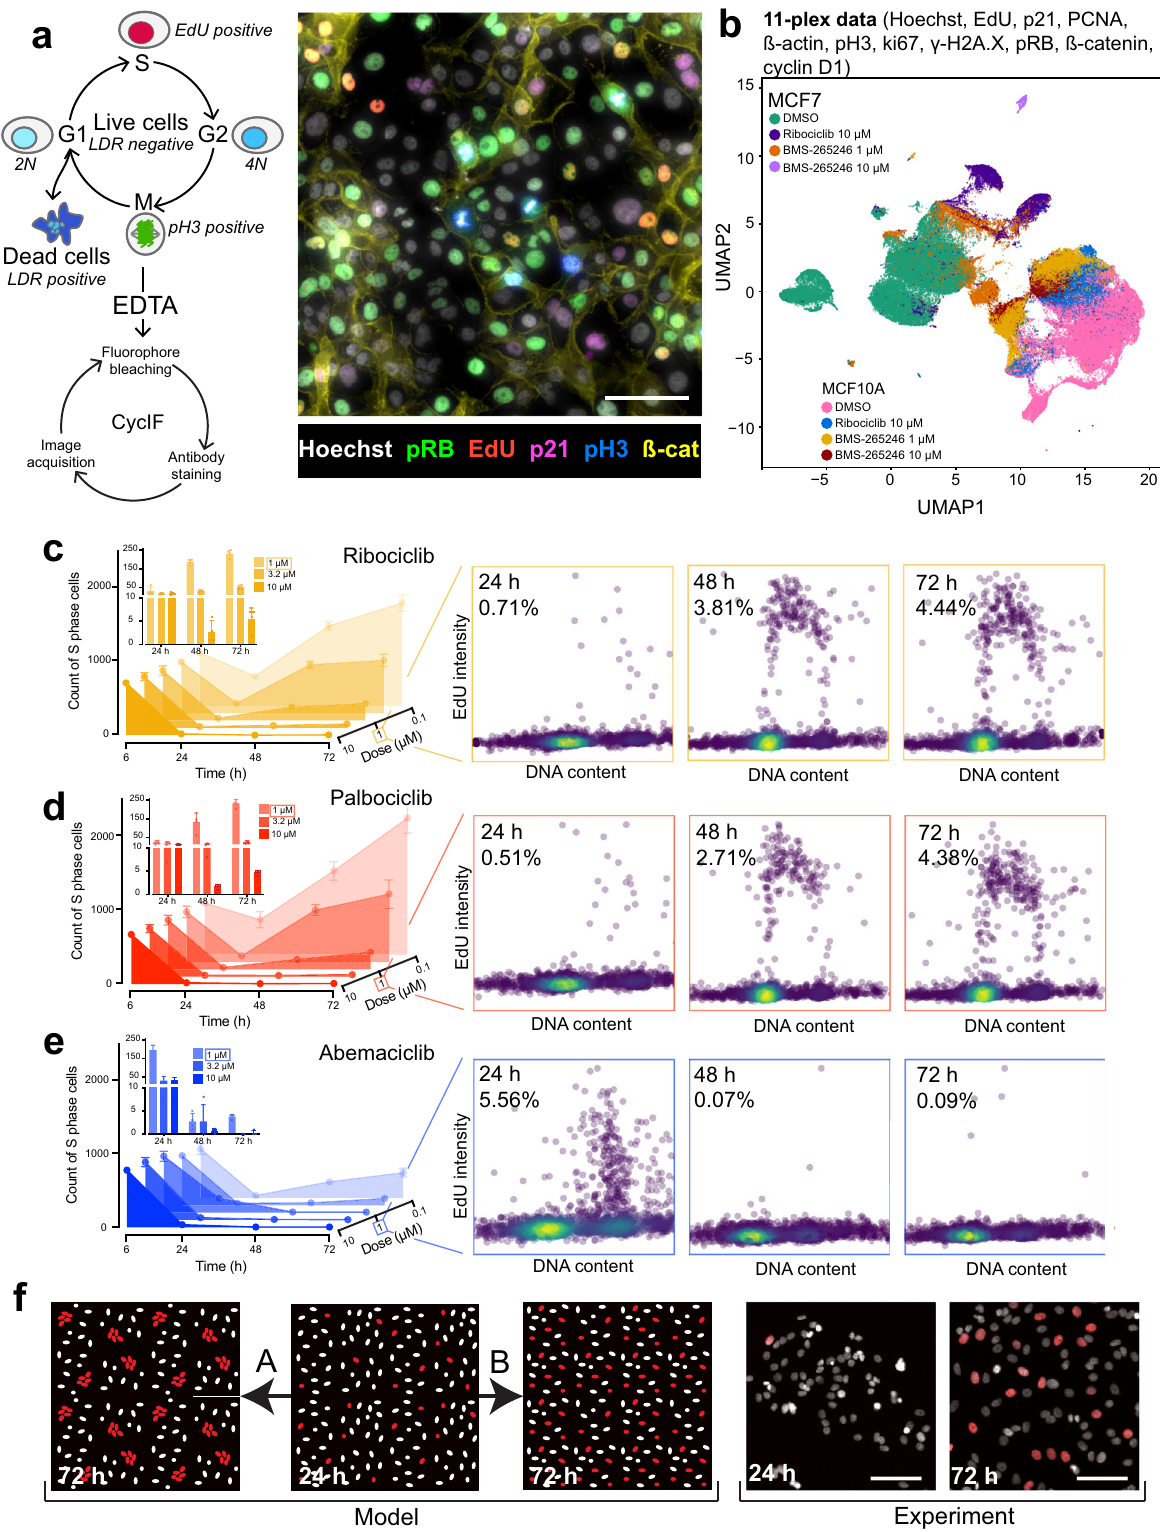
Using Dye Drop to systematically screen small molecule drugs in breast cancer cell lines To demonstrate the use of Dye Drop assays at scale, a panel of 58 breast cancer cell lines was exposed to a library of 67 approved and investigational kinase inhibitors and other small molecules. The panel included multiple non-malignant breast epithelial lines (labeled NM)